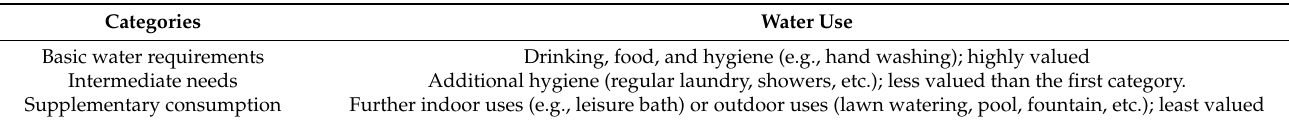
Table 1. Categories of households’ water